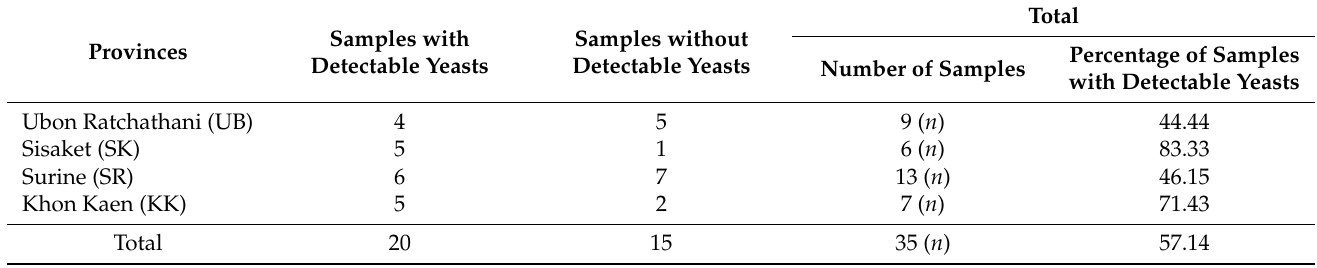
Table 2. The number and percentage of yeast detected and non-yeast detected fresh market samples from different provinces in